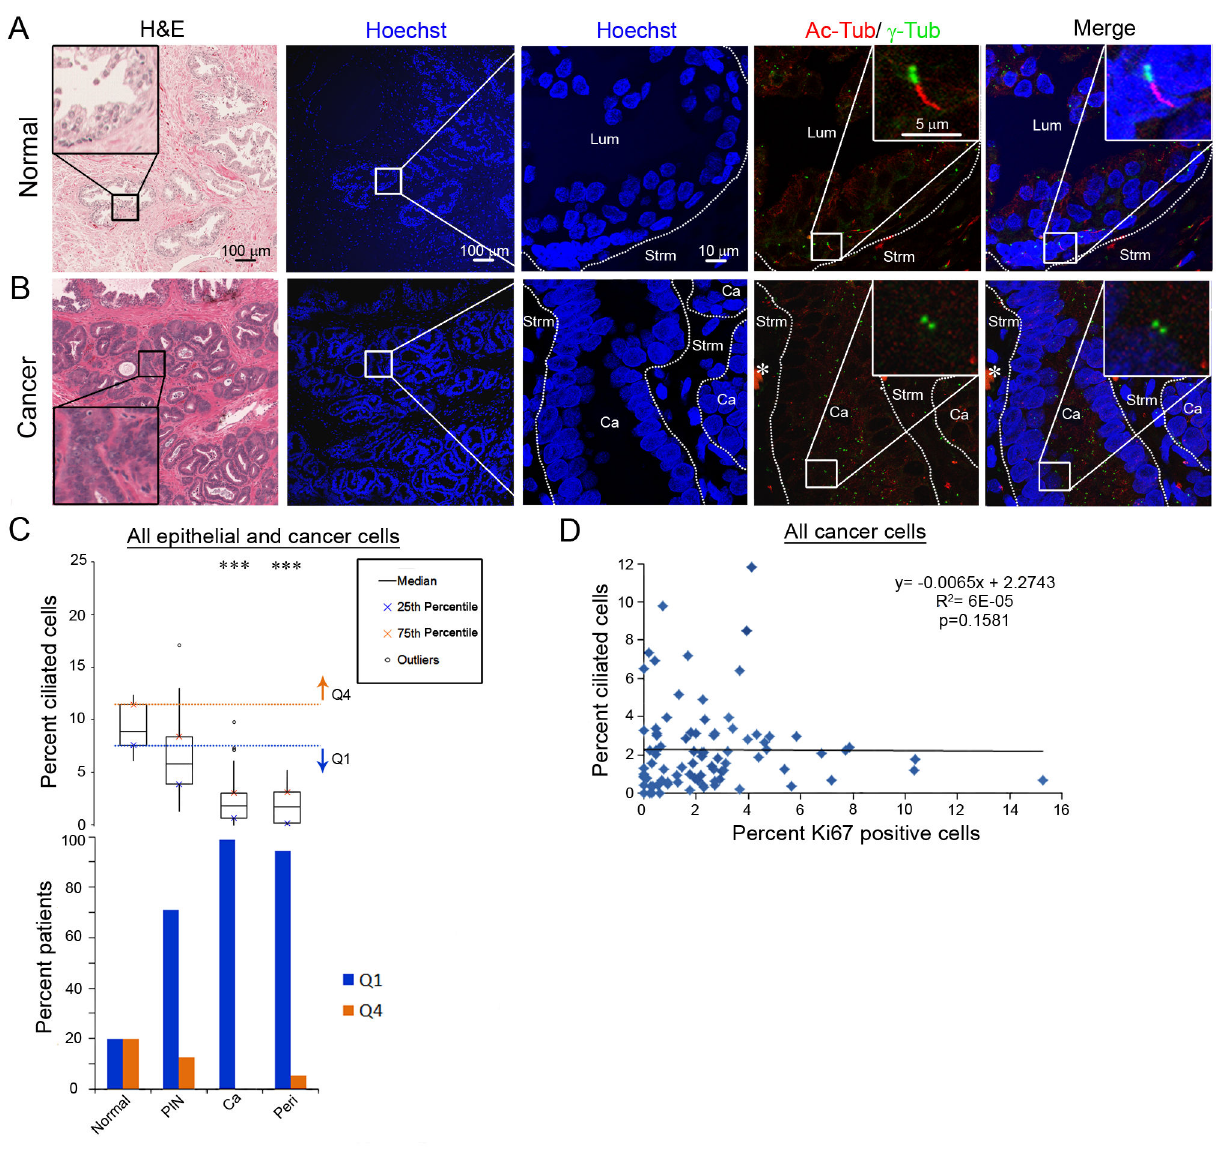
Figure 1. Primary cilia expression is decreased in preinvasive and invasive prostate cancer. Images of (A) normal prostate and (B) invasive prostate cancer. Serially adjacent slides were stained with H&E to visualize tissue morphology or stained fluorescently for nuclei (Hoechst; blue), primary cilia (Ac-Tub; red) and centrosomes (γ-Tub; green). Labeled structures are lumen (Lum), cancer (Ca), and stroma (Strm). Inset shows magnification of (A) a primary cilium on a normal epithelial cell and (B) a centrosome without a cilium on a cancer cell. Asterisk denotes nonspecific staining (C, top). Box plot of the percent of ciliated epithelial and cancer cells per patient for each tissue type: normal, prostatic intraepithelial neoplasia (PIN), cancer (Ca), and perinerual invasion (Peri). Orange line and arrow correspond to Q4 (quartile 4; greater than the 75 th percentile for normal tissue) and blue line and arrow correspond to Q1 (quartile 1; less than or equal to the 25 th percentile for normal tissue). Statistics were performed using linear regression (*** = p<0.001) (C, bottom). The percent of patients with an abnormally high percent cilia (Q4; orange) or an abnormally low percent cilia (Q1; blue). (D) Percent of Ki67 positive invasive cancer cells and perineural invasion cancer cells per patient (x-axis) versus percent ciliated cancer cells for the same patient (y-axis). Statistical analysis was a non- parametric spearman correlation.